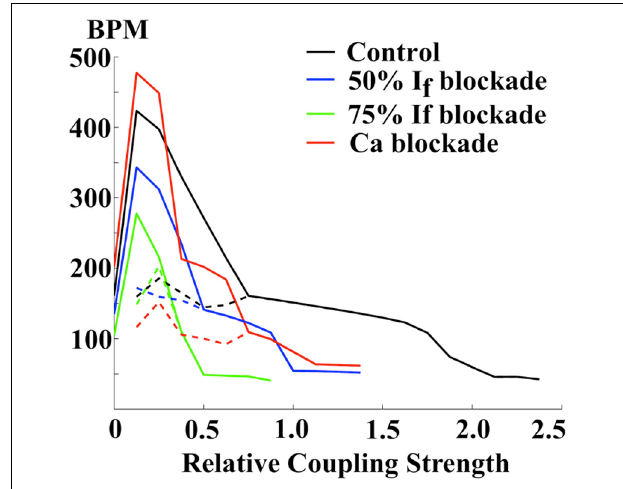
FIGURE 12 | The relationship between pacing rates (in beats-per-minute (BPM)) and the SAN-atrial electric coupling, and the effects of I f or Ca blockade. Solid lines: the central SAN cell. Dashed lines: the peripheral atrial cell. Dr Edward J. Vigmond, Université de Bordeaux. The mesh com-